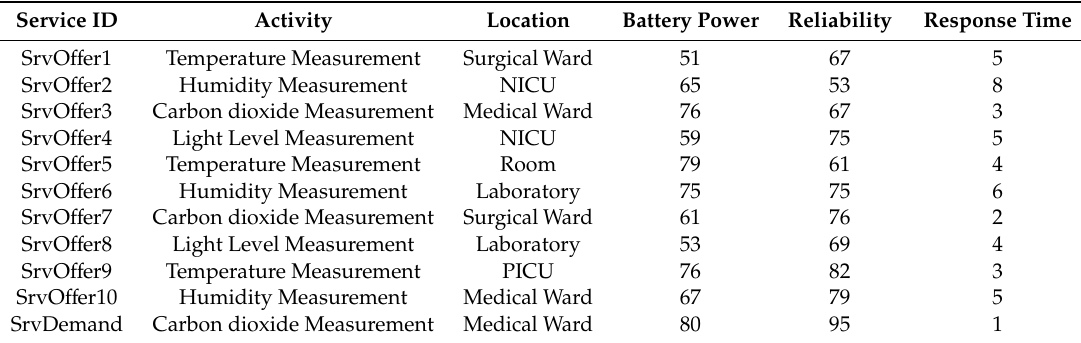
Table 4. High-level description of service o ff ered by devices.